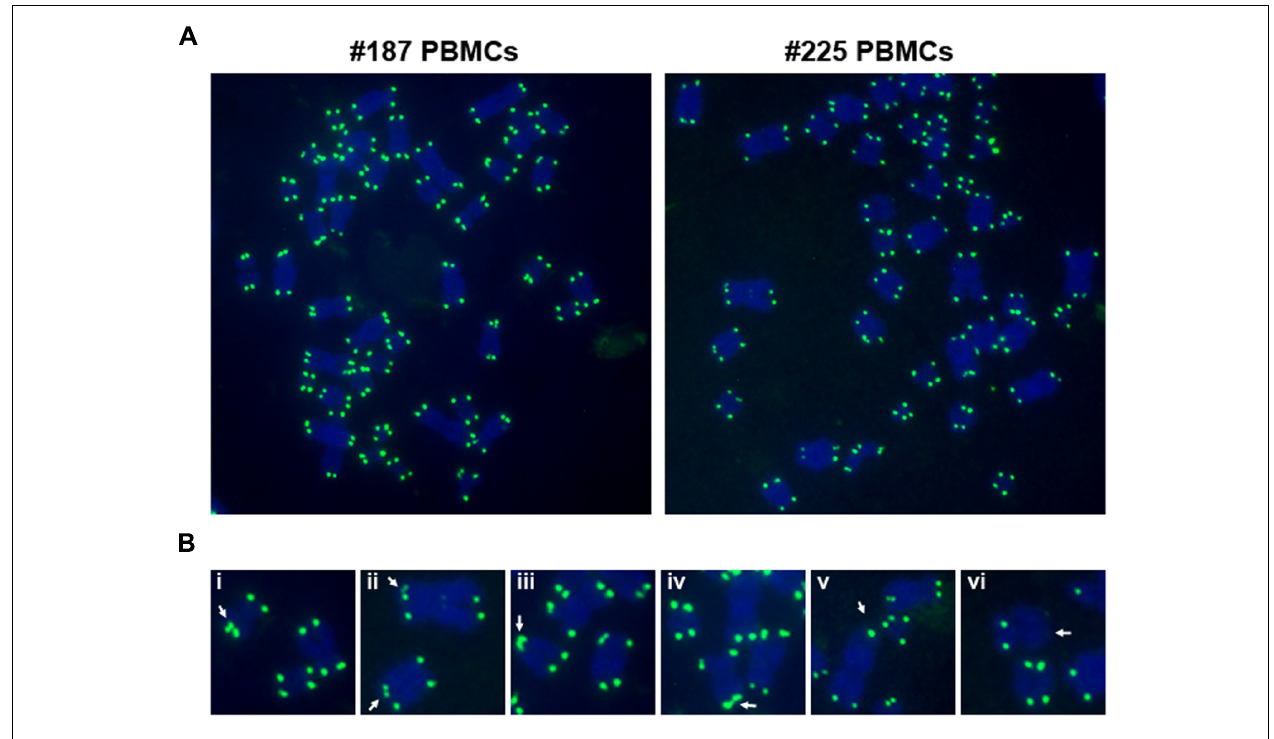
telomeric PNA probe (green). Metaphase chromosomes were stained by Dapi, and shown in blue. (B) Common telomere aberrations in infected cells were shown as enlarged images. Arrows indicate telomere doublets (i–ii), telomere end fusions (iii–iv), and telomeric signal free ends